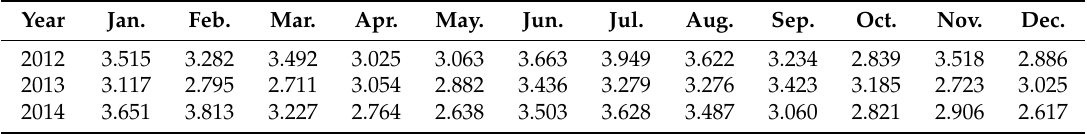
Table 10. The augmented wind speed due to VRGV design at the location of the eco-roof system (m/s).